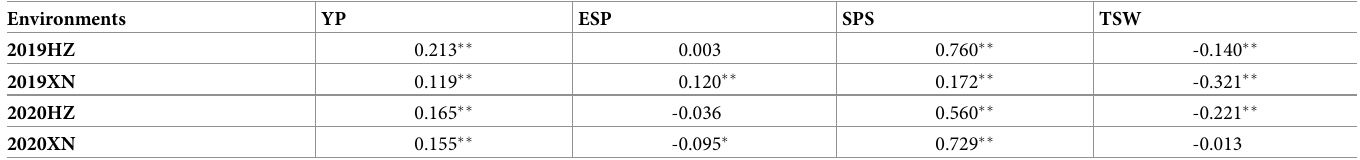
Table 4. Correlation analysis of SD and yield-related traits.